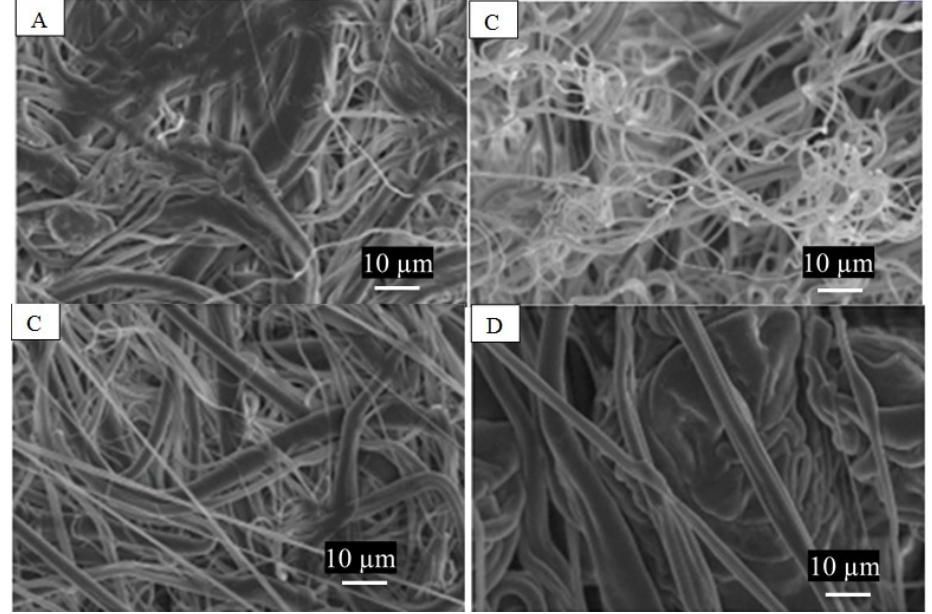
Figure 6. SEM images of PCL fibers prepared from 12.5 wt% PCL solutions in solvent ratios of 30:70 (DMF:THF) mixtures and at different rotational speeds. ( A ) 5000 rpm; ( B ) 6000 rpm; ( C ) 7000 rpm; ( D ) 8000 rpm.